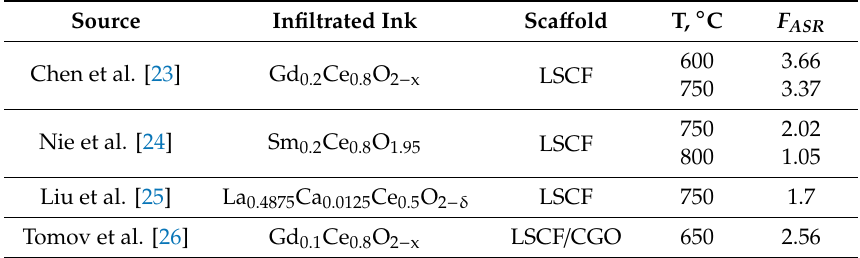
Table 1. Improvement factor ( F ASR ) comparison of doped ceria infiltrated La 0.6 Sr 0.4 Co 0.2 Fe 0.8 O 3 − δ (LSCF)